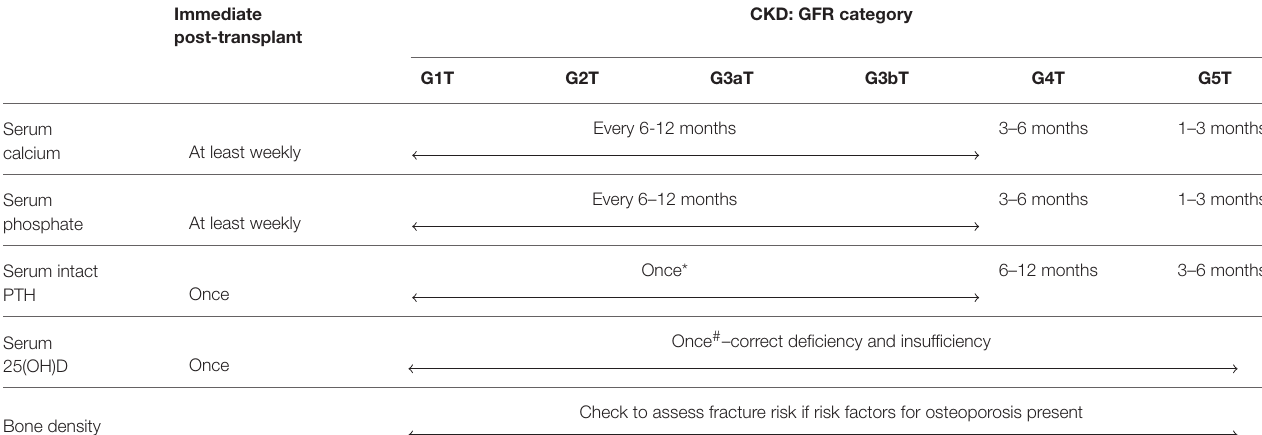
TABLE 2 | Proposed biochemical testing in kidney transplant